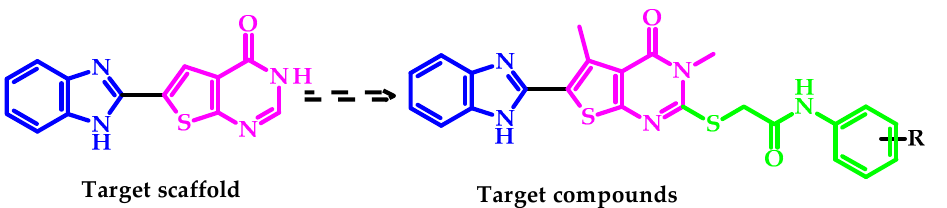
Figure 2. Design strategy for target compounds with antimicrobial activity.